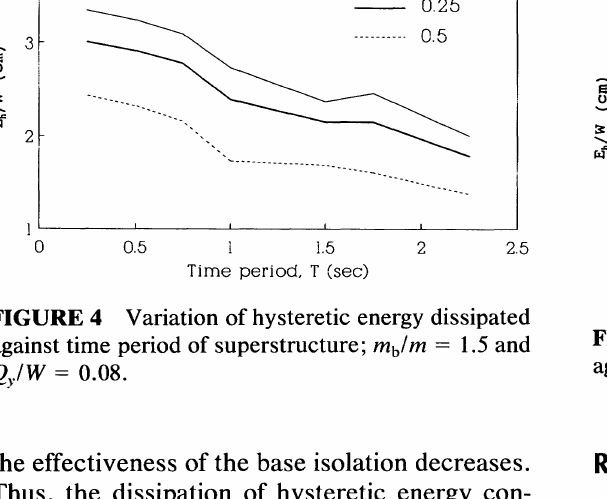
FIGURE 5 Variation of response ratioR against time period of superstructure; mb1m = 1.5 and Q/W = 0.08.